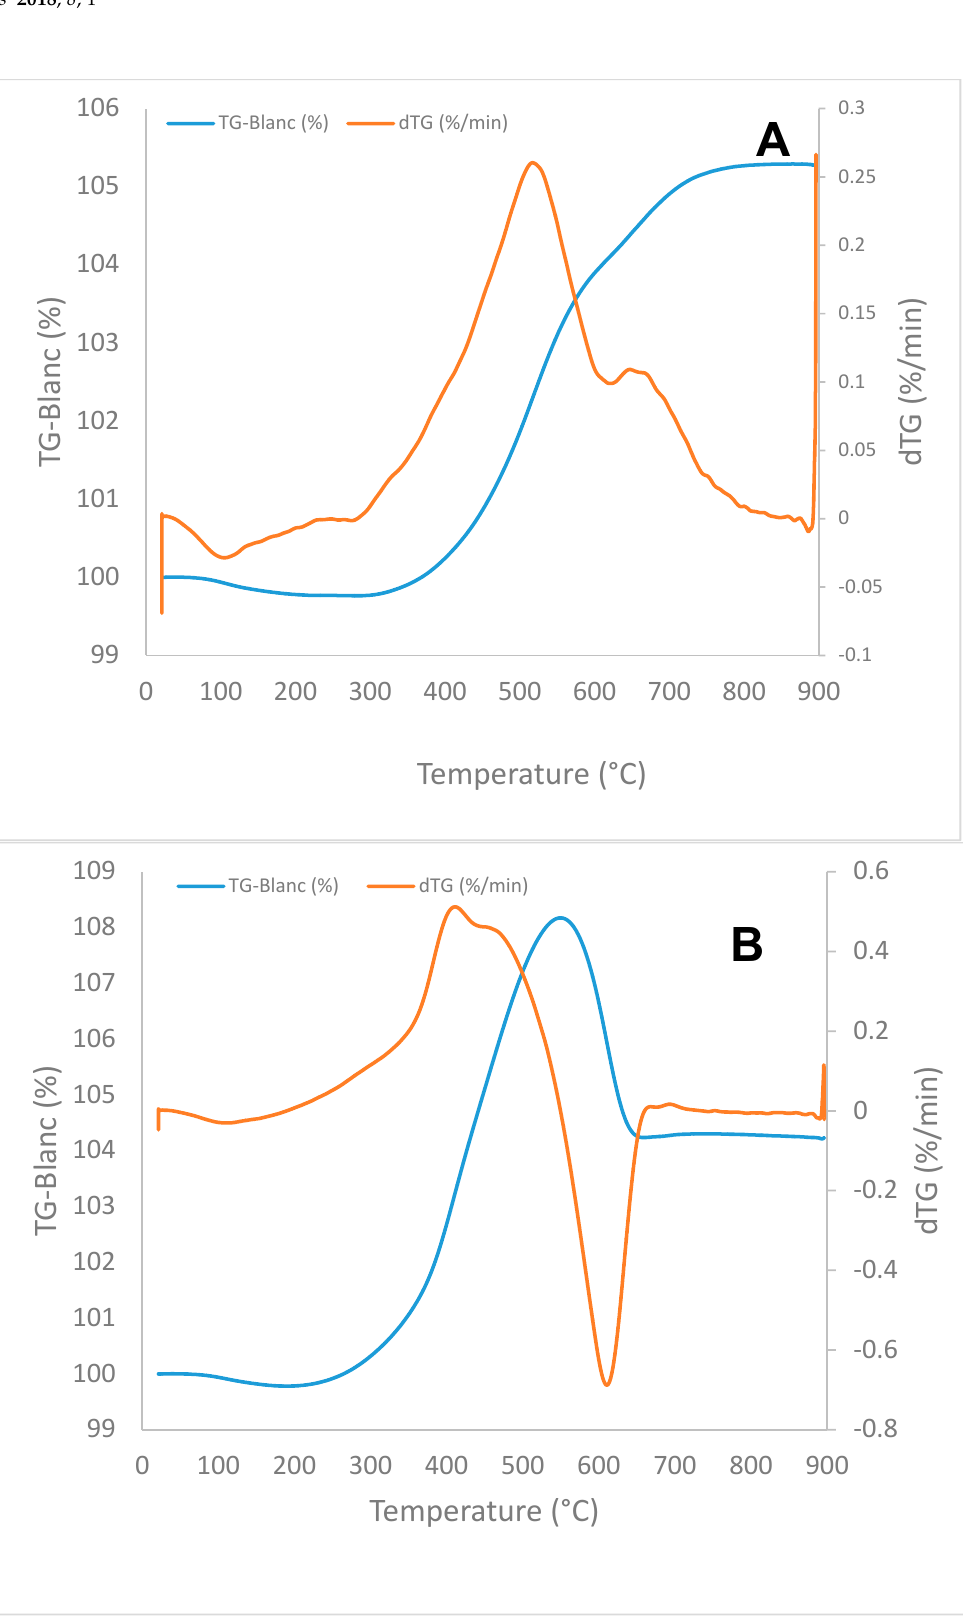
Figure 15. TGA results of Ni-UGSO after SR at T = 775 °C and low WHSV: ( A ) bio-oil WU; and ( B ) bio-oil MemU.